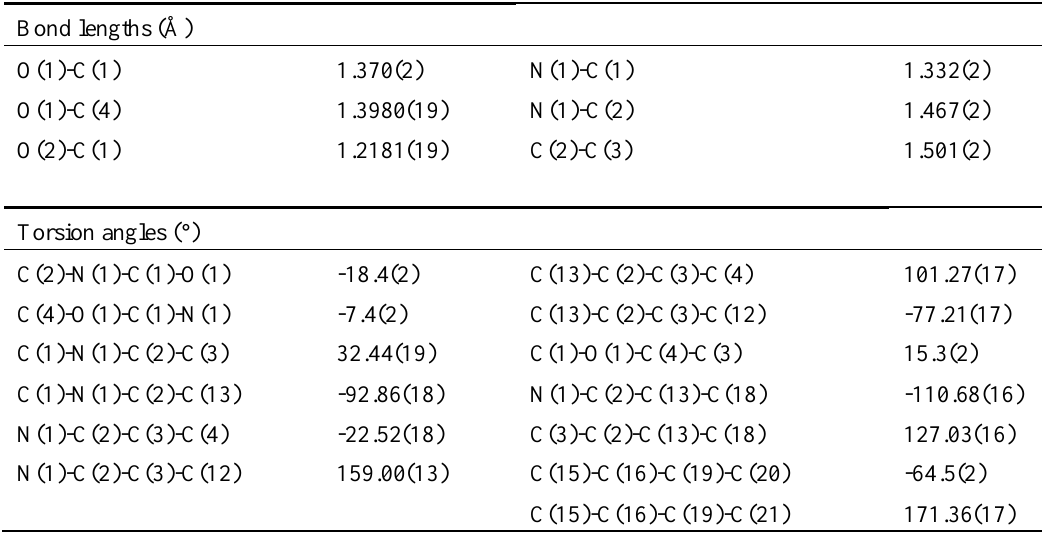
Table 4. Selected Interatomic Distances and Torsion Angles of